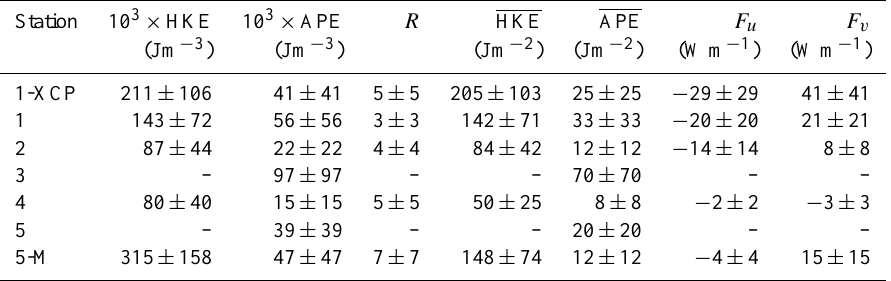
Figure 3. Profiles of amplitude and phase of baroclinic u , v , and ξ obtained from the semidiurnal fits to VM-ADCP and MSS profiles at stations (a) 1, (b) 2, and (c) 4. Also shown are the corresponding barotropic amplitude (vertical lines for u and v , and slanted lines for ξ ) and phase (vertical lines), inferred from identical harmonic analysis of the depth-averaged currents and profile of barotropic displacement. Table 2. Semidiurnal baroclinic energetics at observation stations. Results are shown for the sum of the first three baroclinic modes. An overbar indicates integration over depth; 1-XCP is station 1 with results obtained from the XCP profiles; 5-M is the mooring located near station